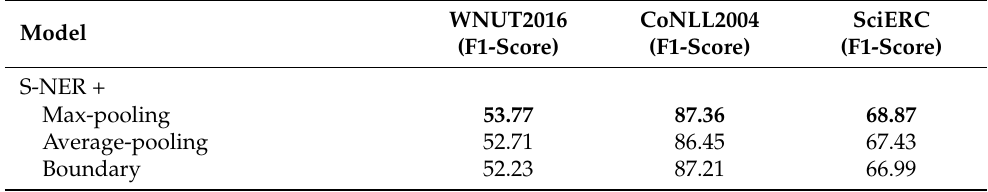
Table 7. Performance compared to that of various approaches for obtaining span representation, evaluated on the dev sets of the three benchmark datasets. Bold values denote the best results.